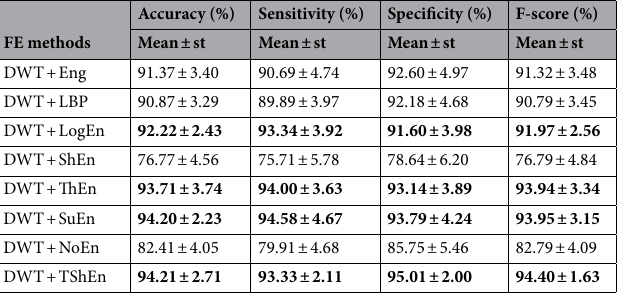
Table 8. Classification results of on-PD versus HC using KNN classifier. Significant values are in [bold].